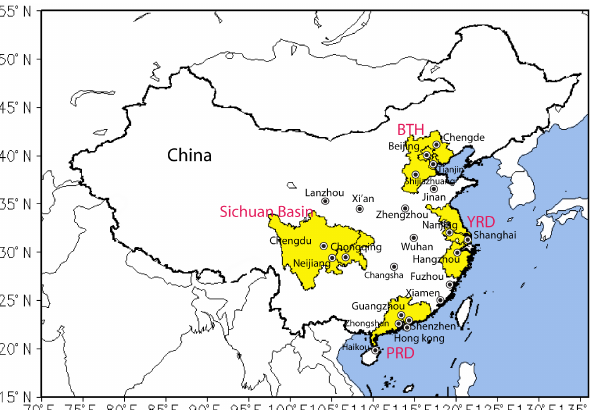
Figure 1. Geographical regions and location of cities with measure-